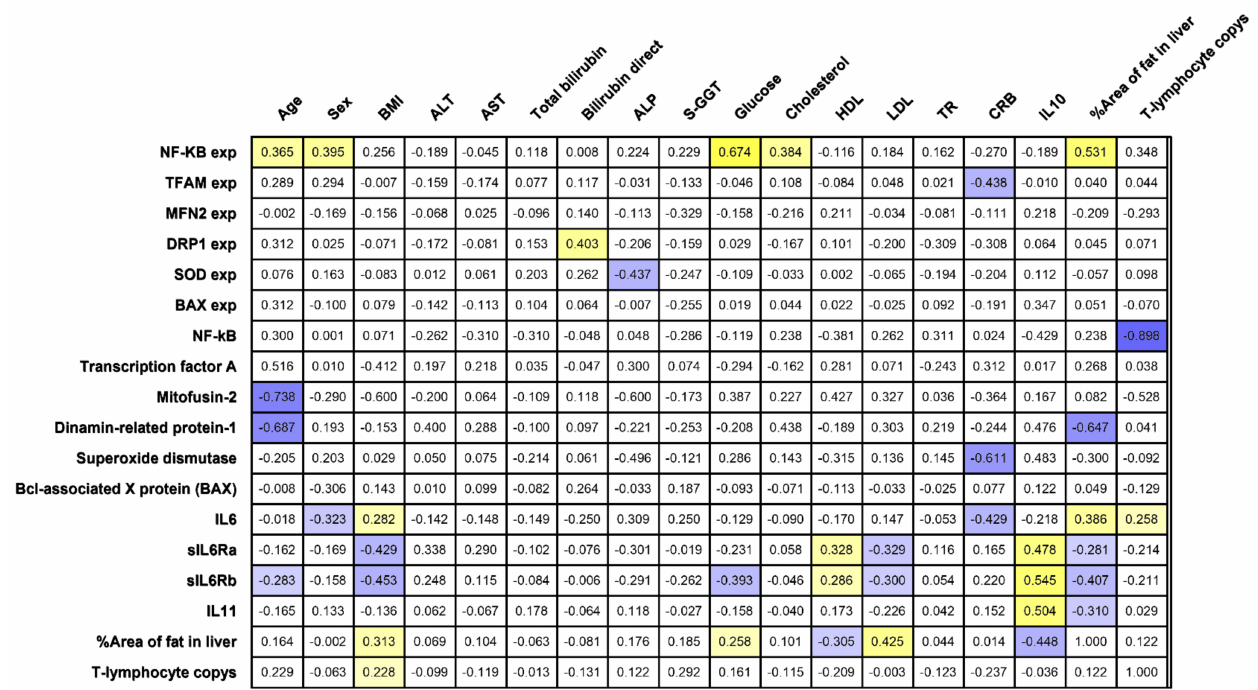
Figure 1. Correlations between the studied parameters in obese patients. Significant positive correlations are indicated in yellow; significant negative correlations are indicated in